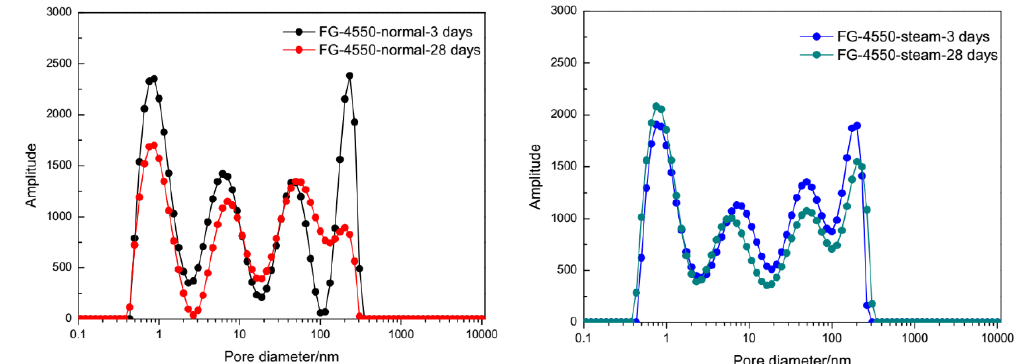
Figure 8. Pore diameter distributions of FG‐4550 pastes under different curing conditions inverted by T 2 relaxation time of NMR.